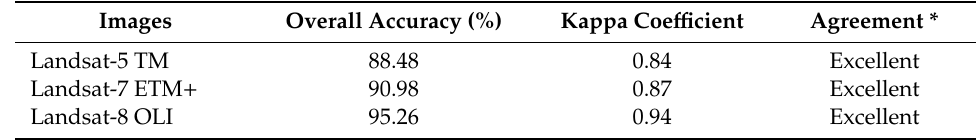
Table 2. Accuracy assessment before pixel trajectory corrections.